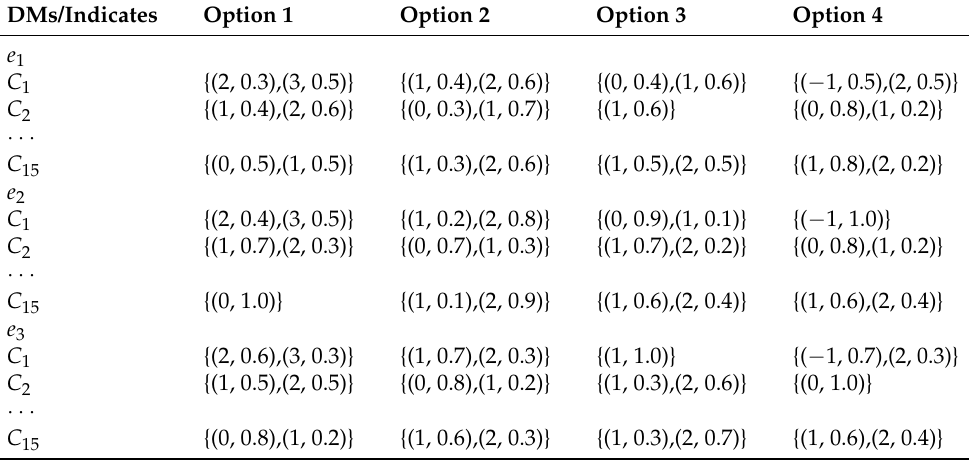
Table 3. The assessment information of CO 2 storage site selection represented by D numbers.